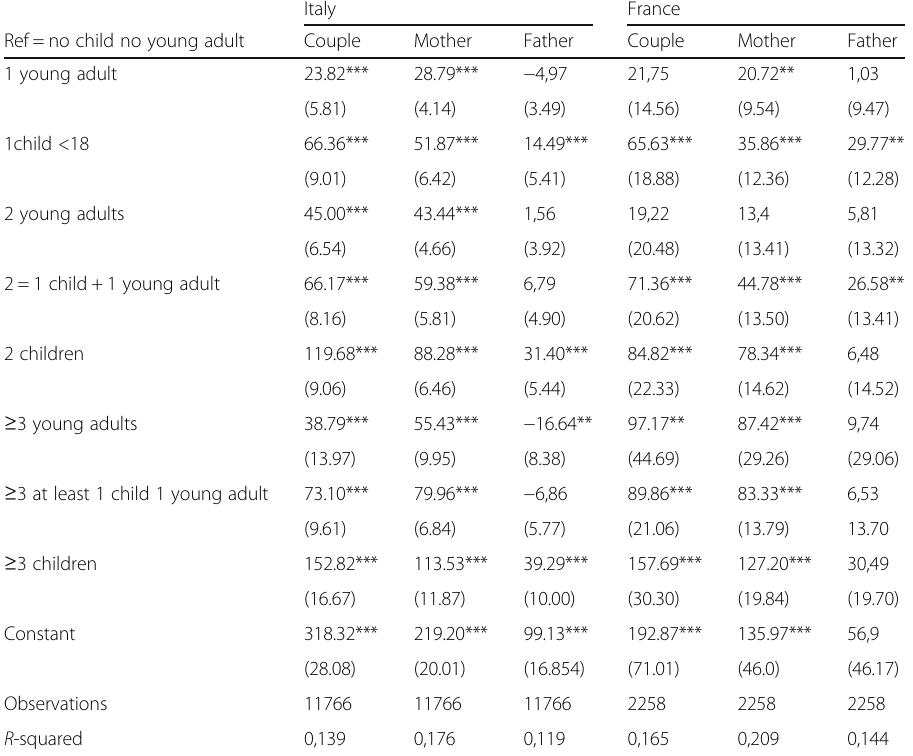
Table 7 Family composition effects on parents ’ participation in domestic activities in minutes per day (OLS